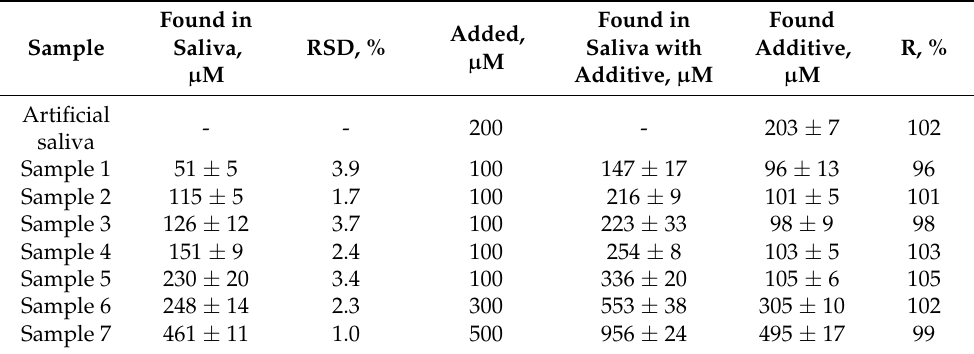
Table 4. Results of salivary UA determination with the use of the proposed sensor CVE act ( n = 3, p =